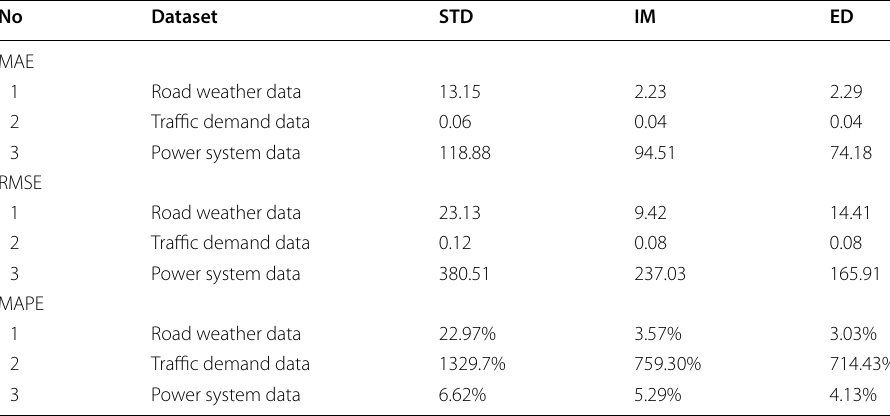
Table 1 Summary of MAE, RMSE, and MAPE result